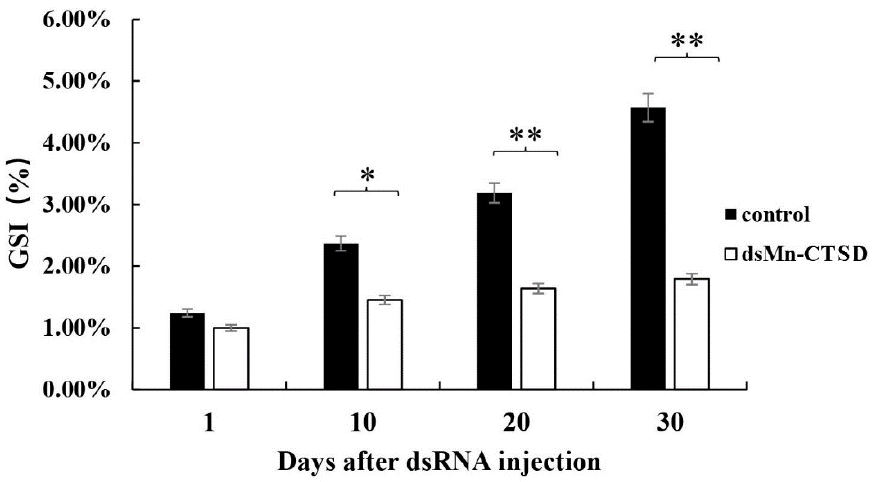
Figure 7. GSI (%) of female M. nipponense after ds Mn-CTSD injection. Data are shown as mean ± standard deviation ( n = 6). Using one-way ANOVA, letters indicated significant differences ( p < 0.05). * denotes statistical significance of p < 0.05. ** denotes statistical significance of p < 0.01.